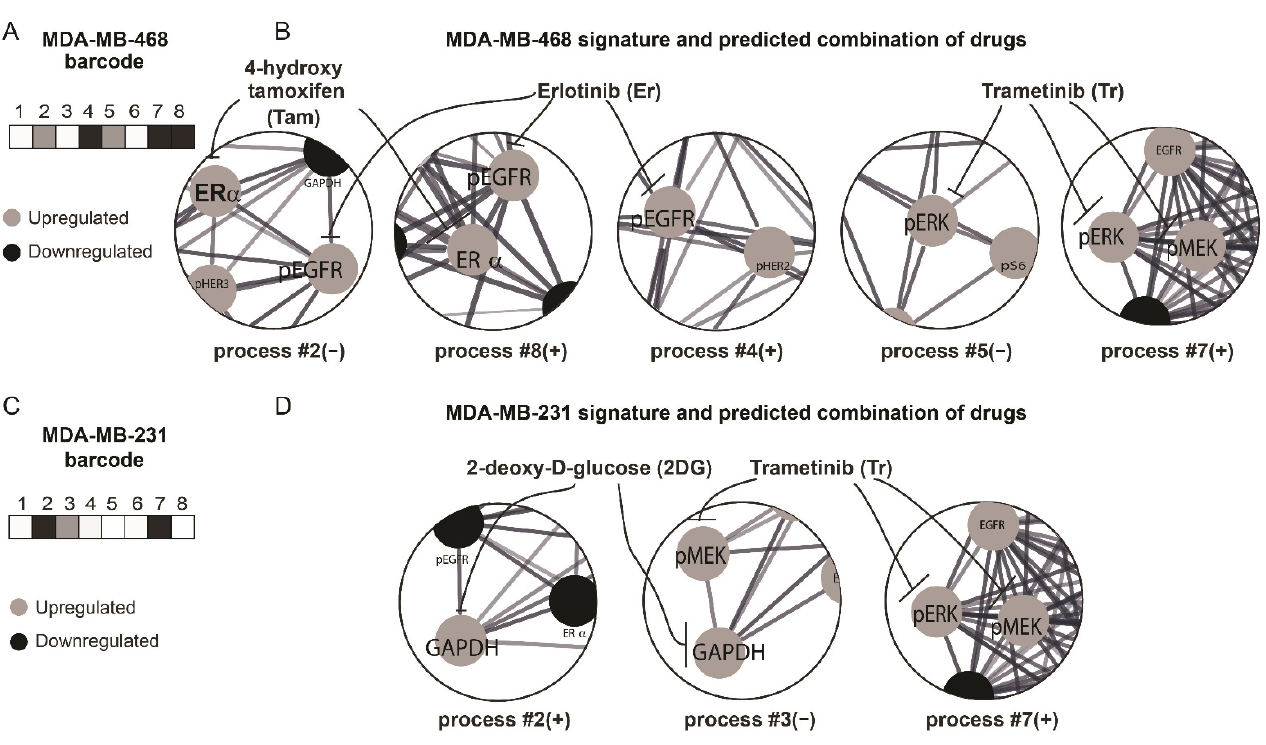
Figure 2. Surprisal analysis predicts efficient drug combinations for TNBC cell lines. ( A , B ) Barcode ( A ) representing the set of unbalanced processes in MDA-MB-468 cells, according to PaSSS analysis ( B ); ( C , D ) Barcode ( C ) representing the set of unbalanced processes in MDA-MB-231 cells, according to PaSSS analysis ( D ). Central protein targets from each process and the corresponding drugs (connected by inhibition arrows) are shown in B and D. (Abbreviations: TNBC—Triple Negative Breast Cancer, pEGFR—phospho Epidermal Growth Factor Receptor, PaSSS—Patient-specific signaling signature, ER—Estrogen receptor, GAPDH—Glyceraldehyde 3-phosphate dehydrogenase, pMEK—phospho Mitogen-activated protein kinase kinase, pERK—phospho Extracellular signal-regulated kinase).